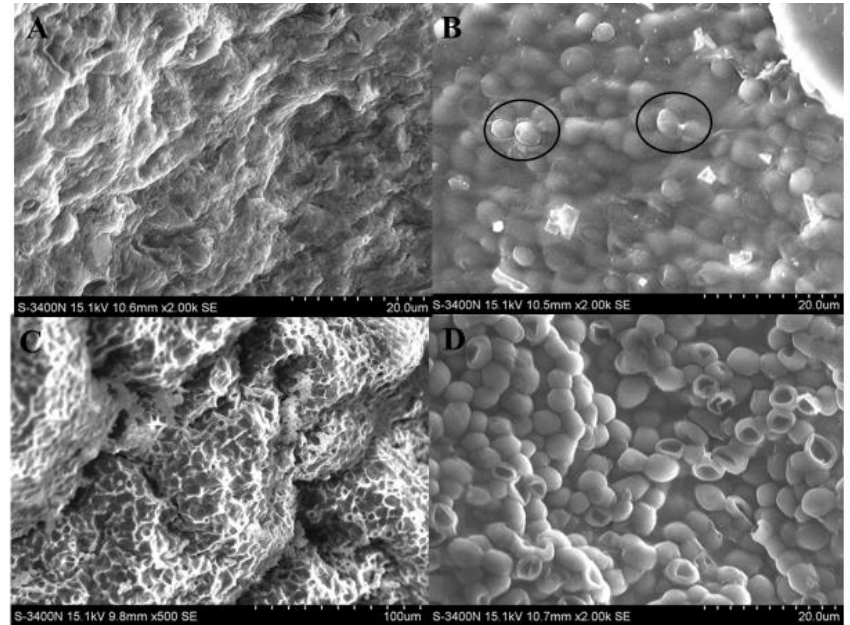
Figure 3. SEM images of ALG carriers ( A ), ALG carriers with cells ( B ), BC-ALG carriers ( C ) and BC-ALG carriers with cells ( D